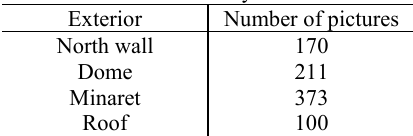
Table 2. Number of pictures